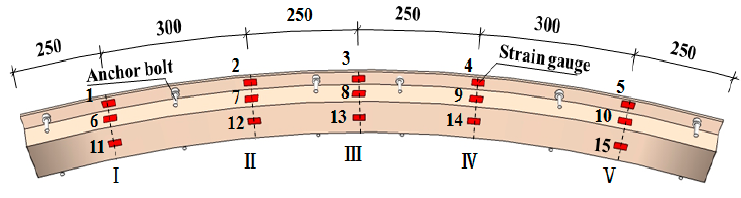
Figure 3. Arrangement of strain gauges (unit: mm).